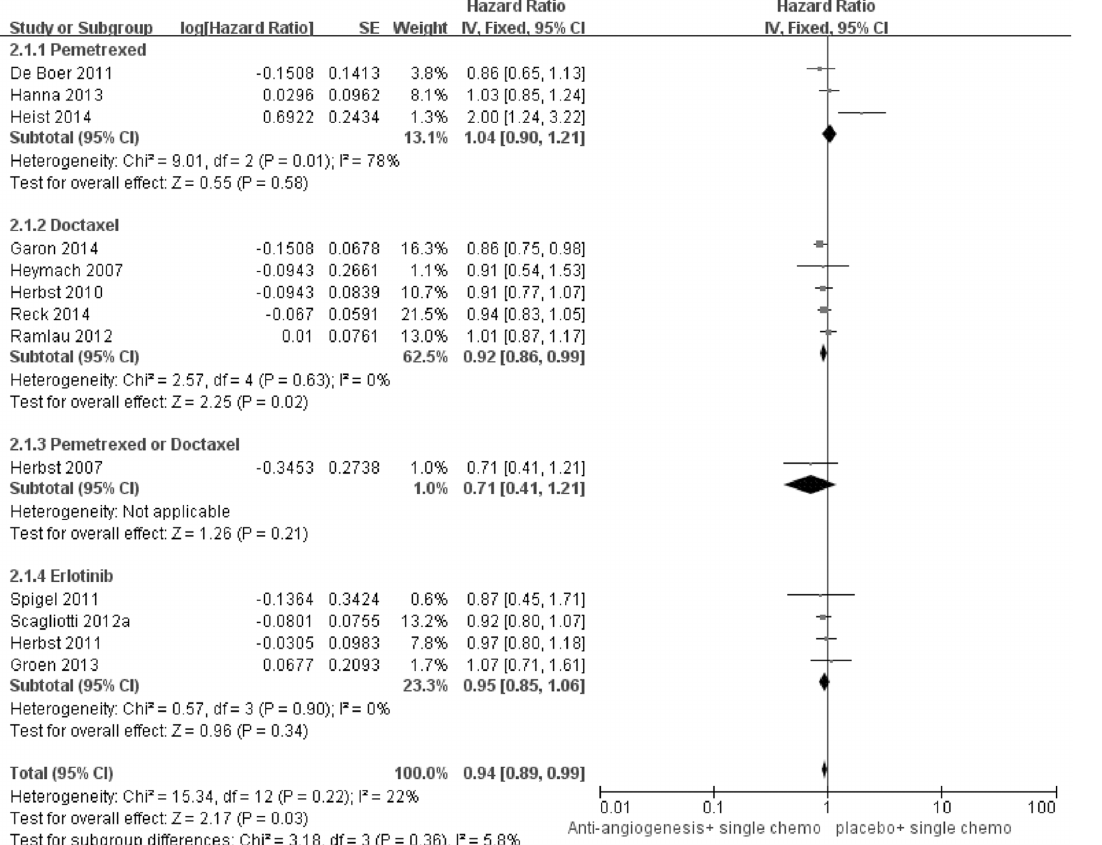
Fig 2. Forest plot and pooled HR & 95%CI for OS: Antiangiogenic agents plus single agent chemotherapy versus standard second-line chemotherapy.